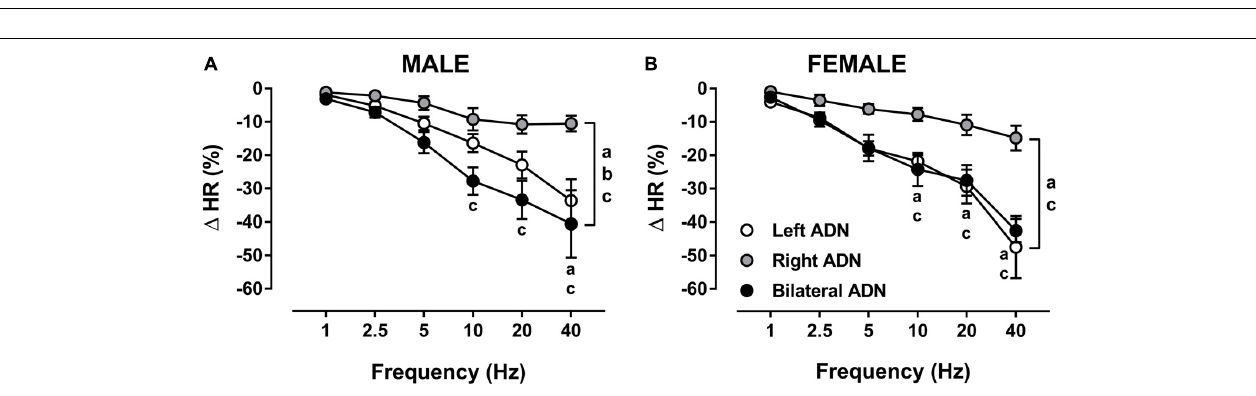
( P = 0.06) left-sided reflex FVR responses than those evoked by the bilateral stimulation; hence, in females, right-sided and bilateral ADN stimulations mediated similar reflex changes